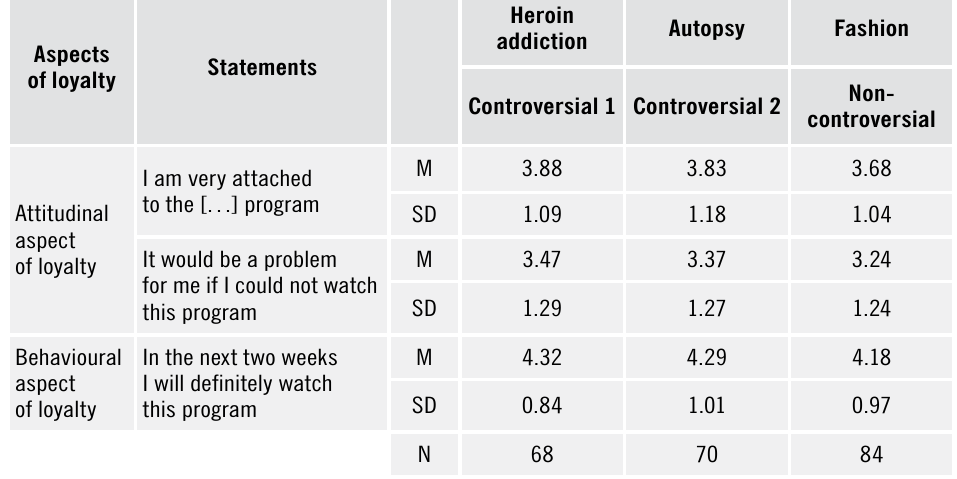
Table 3. Descriptive statistics of statements constituting the loyalty concept